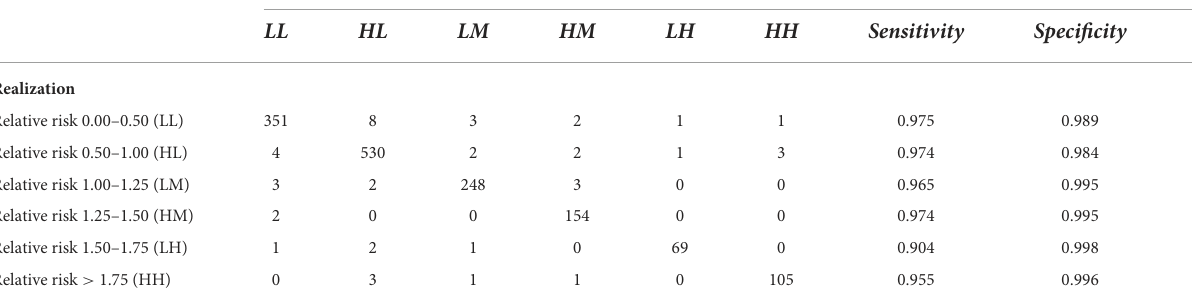
TABLE 7 Confusion matrix for March 2021 prediction of relative risk of COVID-19 infection.